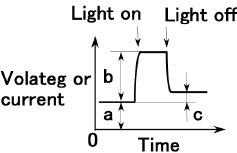
Figure 4. Denoted photoelectricity (photovoltage and photocurrent) as “b”, built-in electricity (built-in voltage and current) as “a”, and charge of built-in voltage and current as “c” which is presented in the consecutive 3rd report on the voltage and electric current curves. Table 1. Components of used 10 types dye by combination of several solutions for wet-type MCF rubber solar cell.